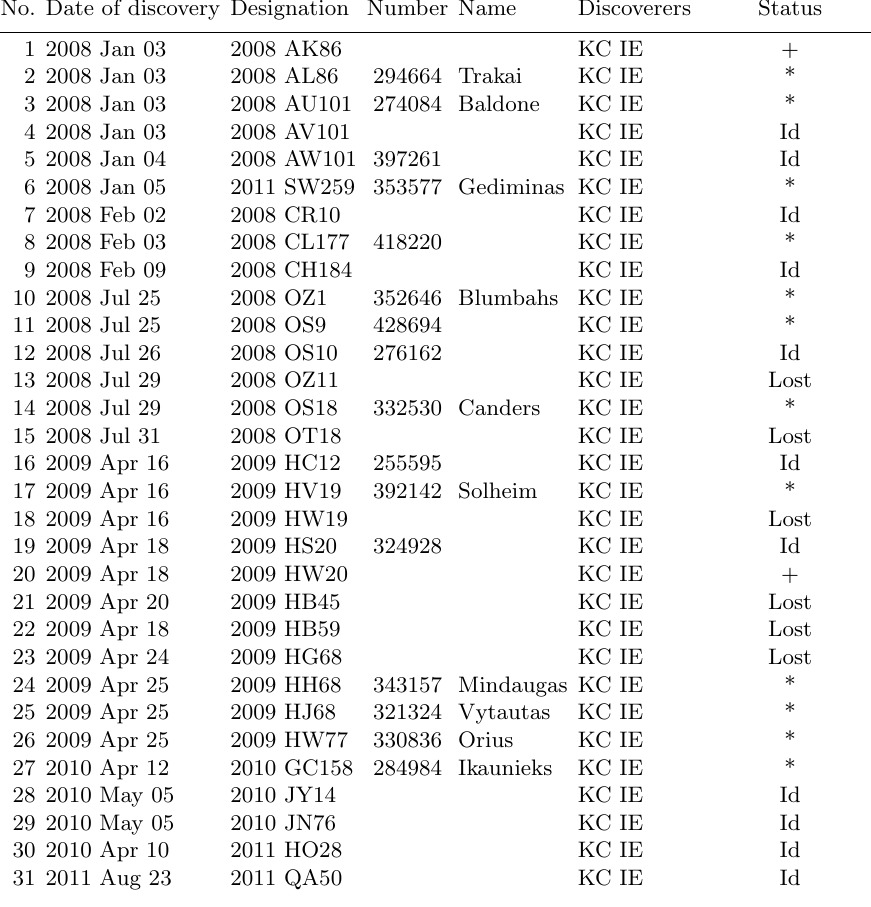
Table 2. List of asteroids discovered at the Baldone Observatory in 2008–2013. No. Date of discovery Designation Number